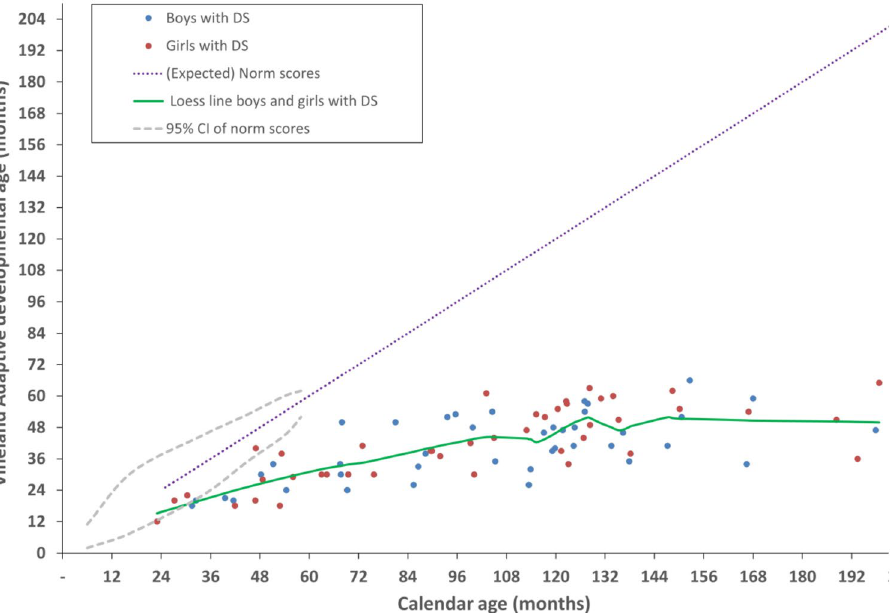
Figure 1. Vineland Adaptive behaviour. Adaptive developmental age as estimated by their adaptive behaviour in the Vineland-S, as a function of calendar age in 83 children with DS. Note that all scores fell below the norm (identity line; n = 979, age range 1–72 months; Sparrow et al. 15,16 ). According to the measurement focus of the Vineland-S, the norm scores of typically developing children equal their calendar age. Blue bullets: Measured boys with DS (n = 40). Red bullets: Measured girls with DS (n = 43). Solid green line: Loess line fitted to the data of the children with DS pooled across boys and girls. Dotted purple line: (Expected) norm scores (mean) of typically developing children pooled across boys and girls. Grey dashed lines: upper and lower bound of the 95% confidence interval of norm scores of typically developing